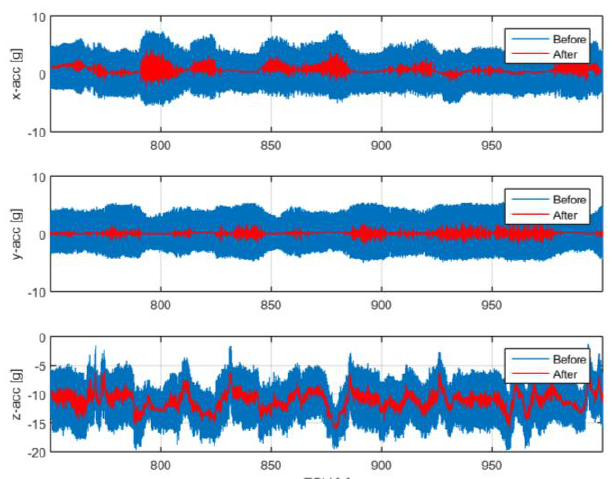
Figure 3. ADIS accelerometer measurements before and after